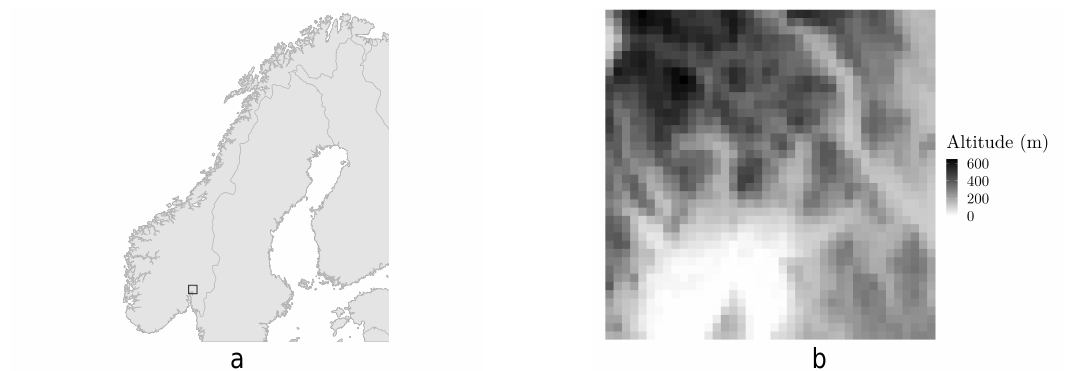
Figure 1. ( a ) The geographical area used in this work, shown as an empty, black square centered around Oslo on a map of Scandinavia. ( b ) The topography of the area used.The Oslo fjord inlet can be seen towards the bottom of the